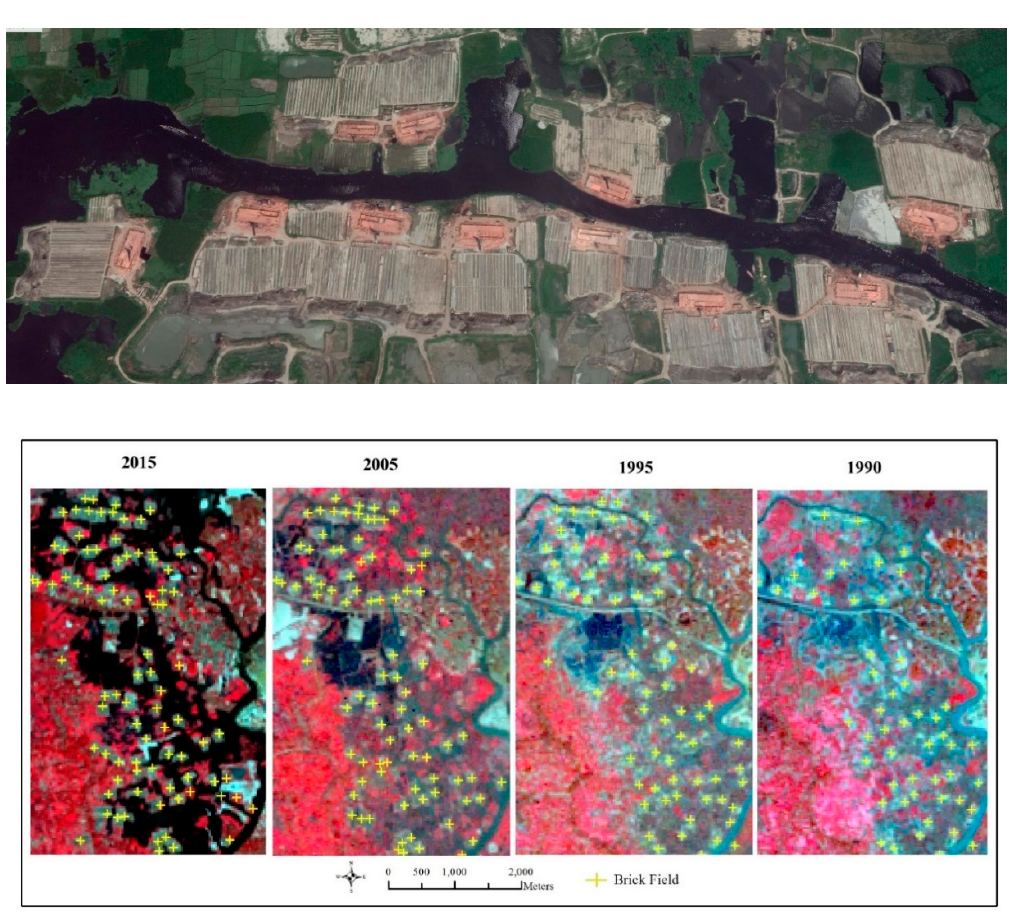
Figure 3. Shape and structure of traditional brickfields visible in high-resolution Google Earth imagery ( top ) and digitized brickfield locations overlaid on false color composite Landsat imagery across the study period ( bottom ).